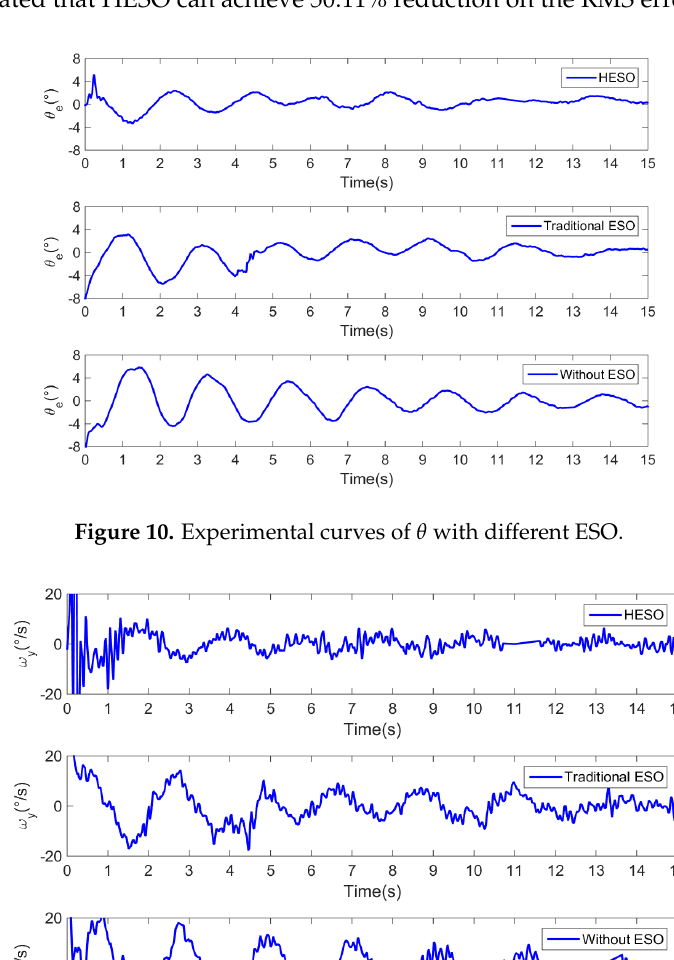
Figure 9. Estimation errors comparison of HESO and traditional ESO in attitude tracking.